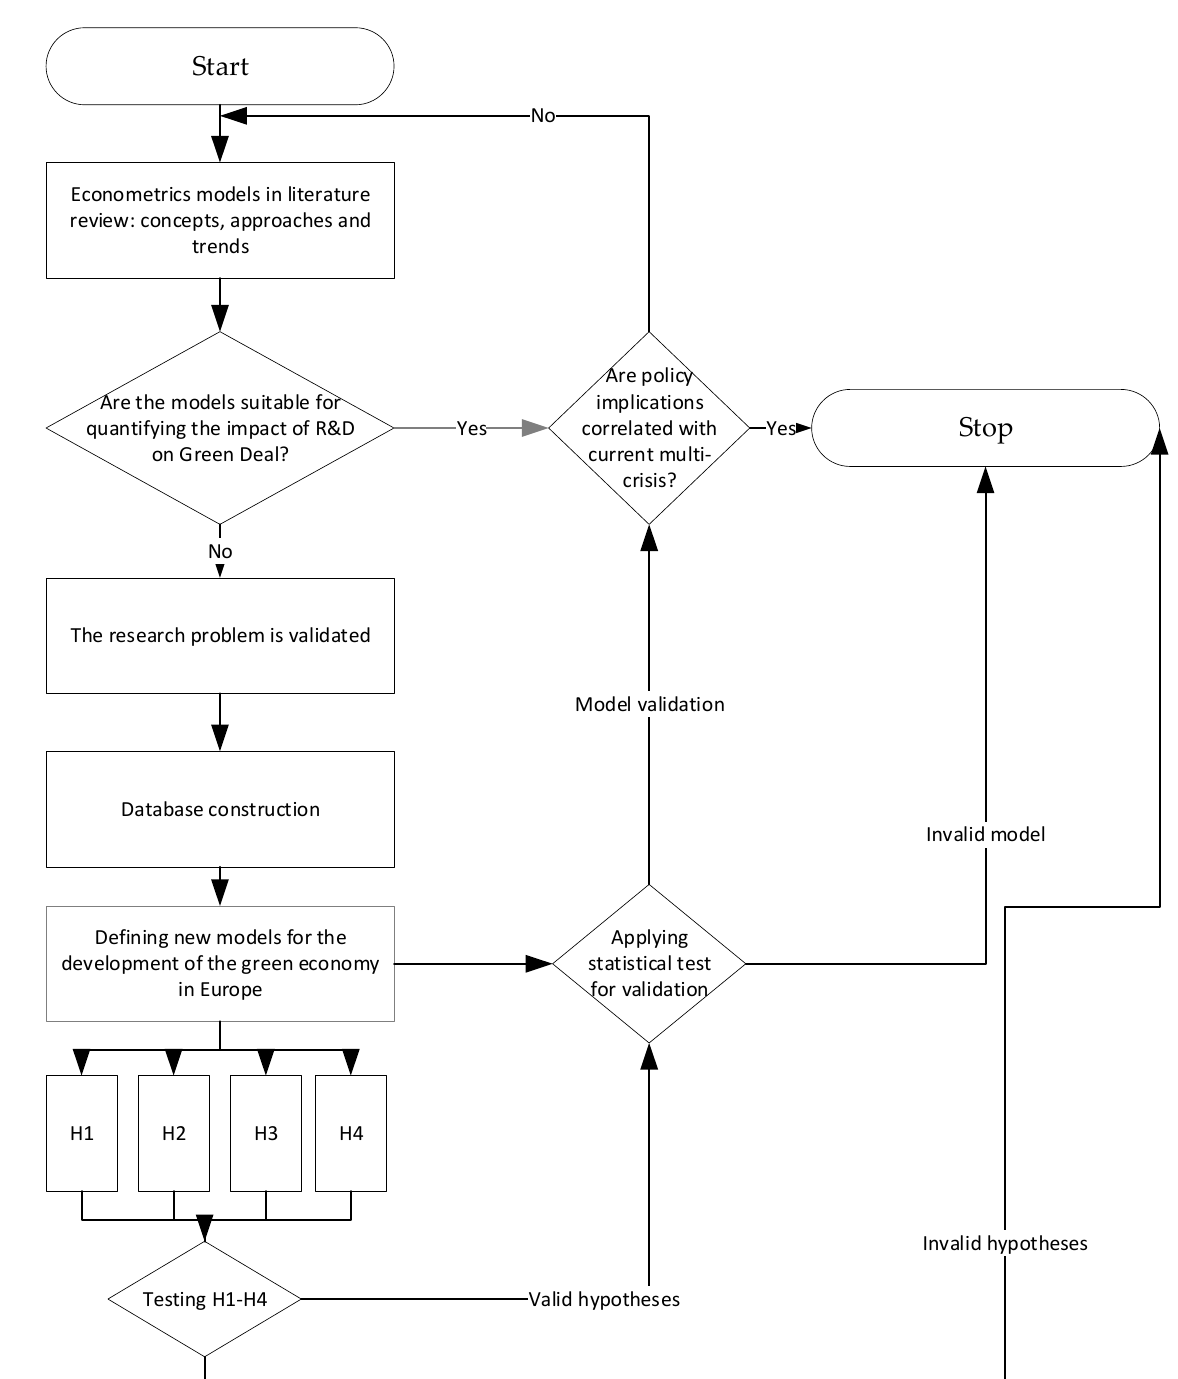
Figure 2. Diagram of the research procedure.